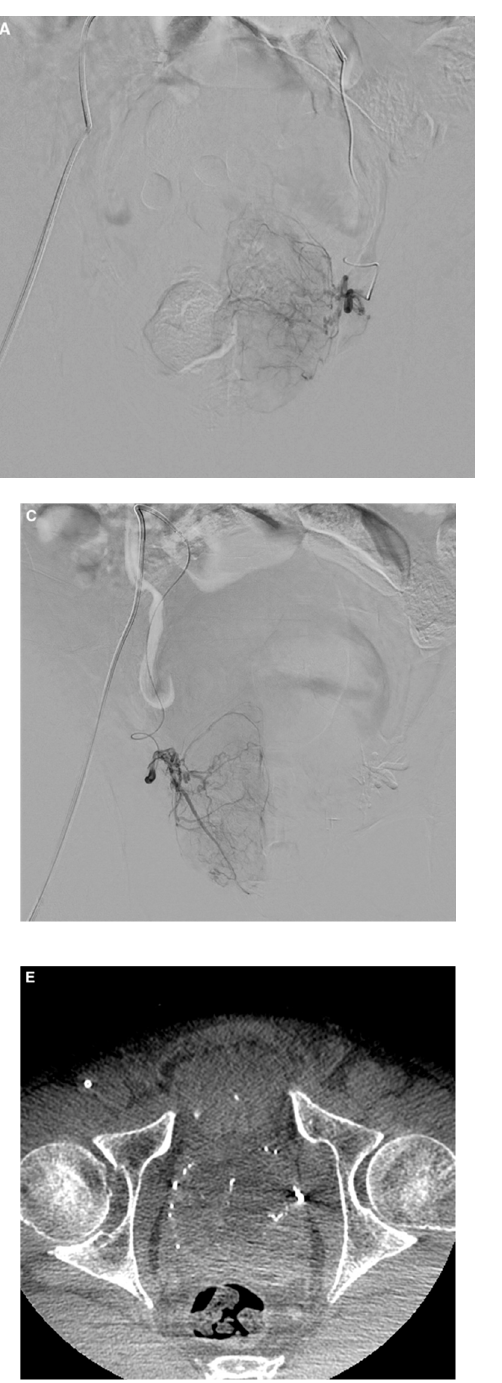
Figure 1. Example of prostate artery embolization (PAE) with N-butyl cyanoacrylate glue in a 74-year-old patient with symptomatic benign prostatic hyperplasia. ( A ) Left prostatic artery angiogram before PAE showing enhancement of the left prostatic lobe. ( B ) Follow-up angiogram after PAE with a mixture of Glubran ® 2/Lipiodol in a 1:8 ratio showing total occlusion. ( C ) Right prostatic artery angiogram with enhancement of the right prostatic lobe. ( D ) Visualization of the glue/lipiodol cast in the branches of the right prostatic artery after injection of the same mixture, with complete occlusion. ( E , F ) Axial cone-beam computed tomography images without contrast injection after bilateral PAE showing lipiodol uptake by both prostatic lobes with distal and proximal distribution of the glue/lipiodol casts. Major improvements in lower urinary tract symptoms were noted 3 months after PAE compared to baseline (IPSS, 5 versus 24; QoL score, 2 versus 6; prostate volume, 110 versus 170 mL).